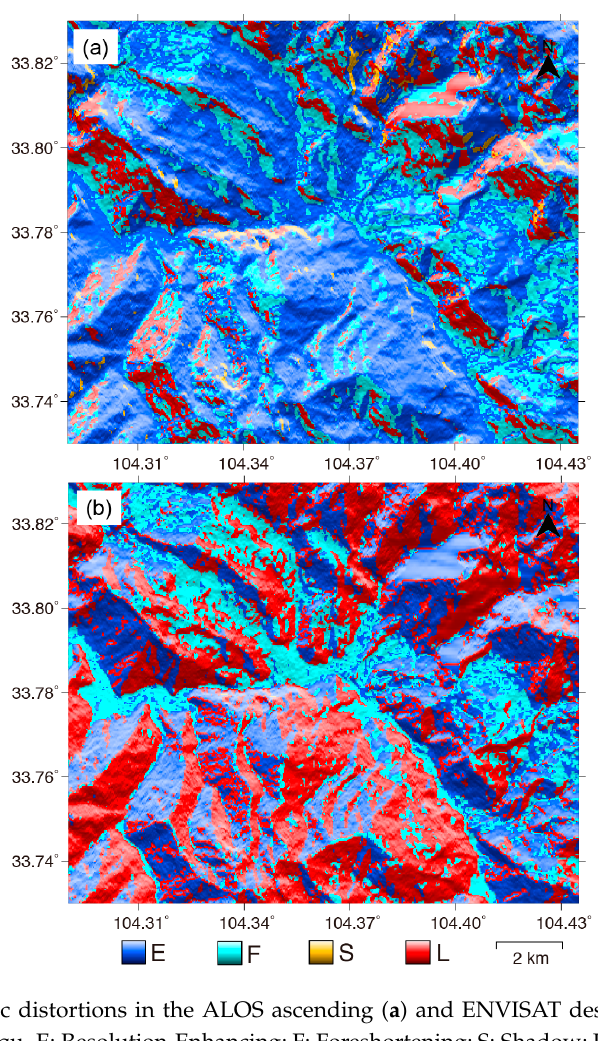
Figure 5. Geometric distortions in the ALOS ascending ( a ) and ENVISAT descending ( b ) images acquired over Zhouqu. E: Resolution-Enhancing; F: Foreshortening; S: Shadow; L: Layover.